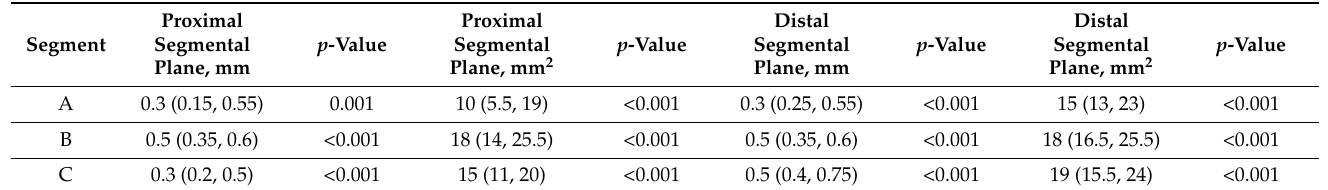
Table 4. Difference between maximum systolic and maximum diastolic diameters and areas a .